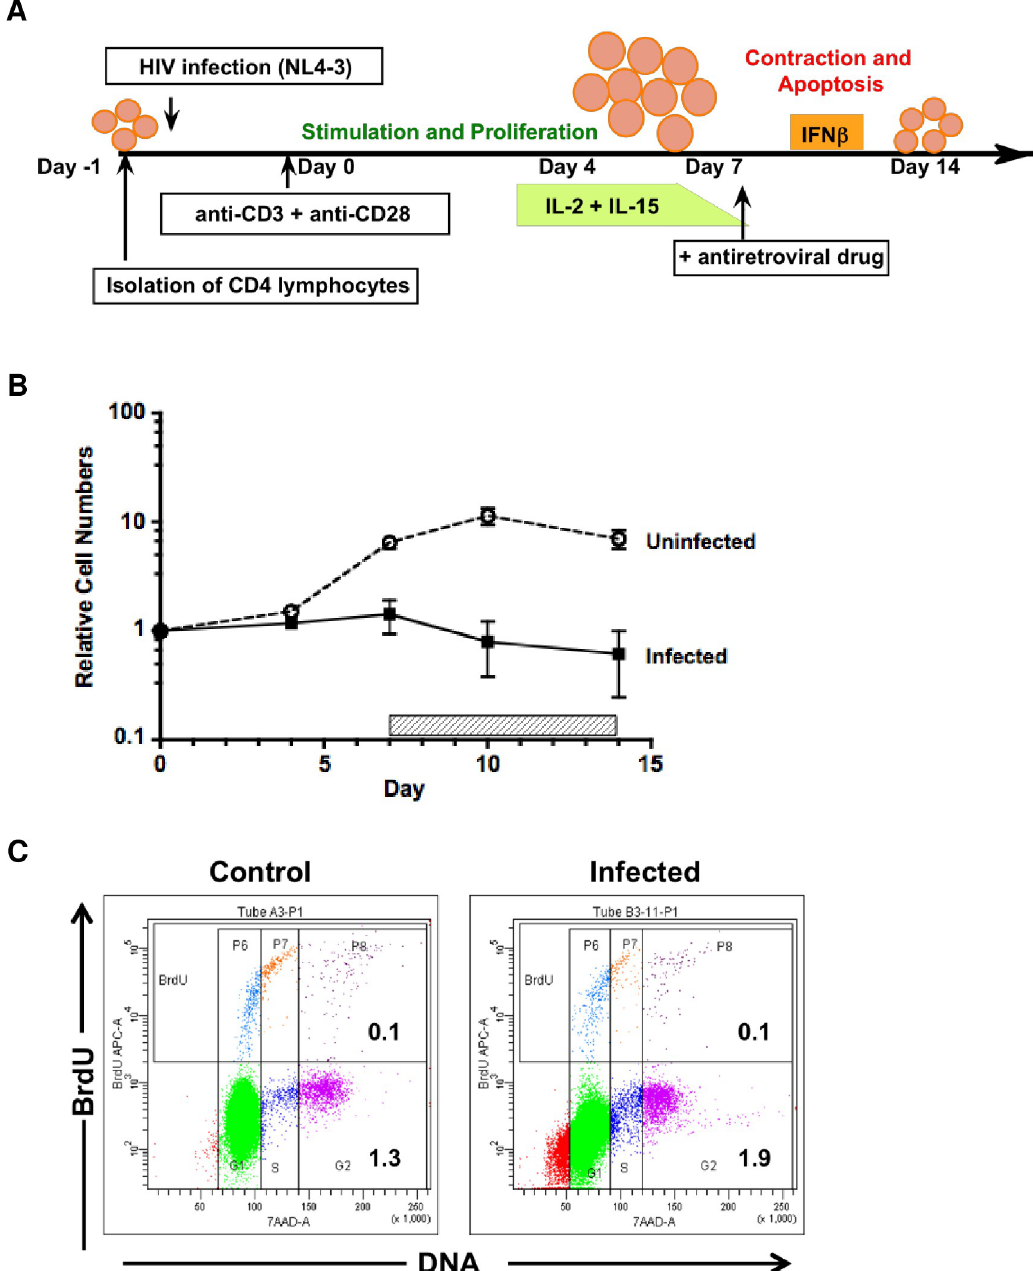
Fig 1. Design and cell characteristics of in vitro culture model. (A) Schematic of primary CD4 T cell culture system. Primary CD4 T cells were isolated by negative selection, infected with the NL4-3 clone of HIV-1, and stimulated through TCR cross- linking with plate-bound immobilized anti-CD3 + anti-CD28 antibodies. After 4 days incubation, cells were recovered and transferred to new culture wells that lacked TCR stimulus. During the expansion phase of culture, cells were maintained in medium supplemented with exogenous cytokines, to enhance proliferation. IL-2 was added on day 4; and IL-15 was added on days 4 and 7. During the contraction phase of culture, interferon-beta (IFN β ) was added to the medium on days 10 and 12, to reduce the level of activation-induced cell death. Antiretroviral drugs were added (Nevirapin, at day 5 or Indinavir, at day 7) to prevent further spread of viral infection (refer to details in Materials and Methods for rationale in drug timing). Resting, infected cells were obtained at the end of culture on day 14. (B) Isolated CD4 T cells were either infected with NL4-3 (MOI = 0.01 TCID 50 ) or mock infected (Uninfected) under similar experimental conditions and cultured in parallel for 14 days, according to the schema depicted in A. Indinavir was added on day 7 and replenished every two days until the end of culture (horizontal hatched bar). Cell number and viability were measured by trypan blue dye exclusion, along with culture volume, throughout the culture